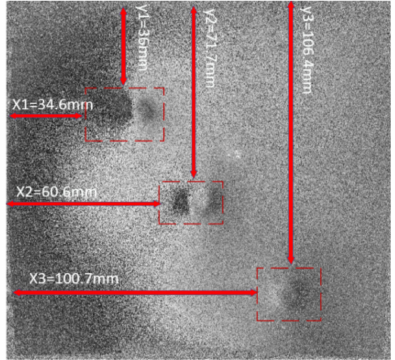
Figure 14. The surface distances of the defects to the